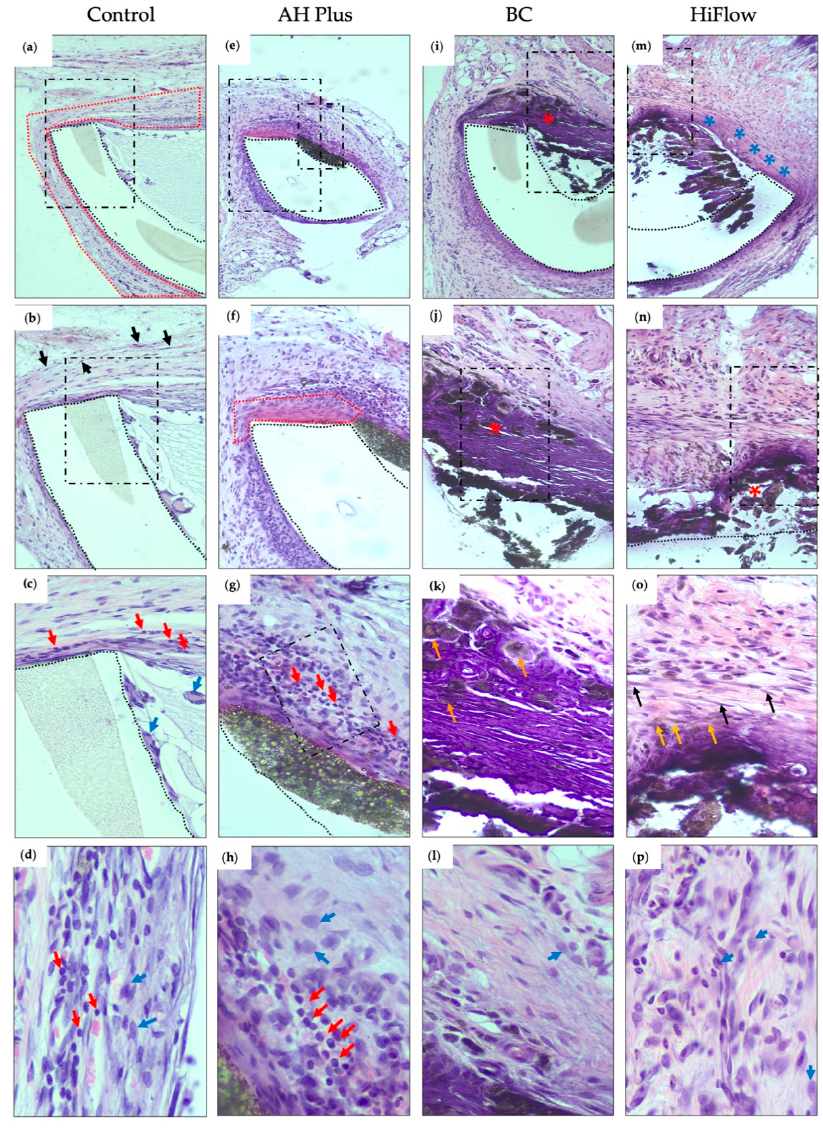
Figure 2. Hematoxylin and eosin histological sections of the interface tissue-sealer 30 days after subcutaneous implantation (dashed boxes mark the view of the subsequent image): ( a ) control group, showing the polyethylene tube (demarcation with dotted lines) and content surrounded by a thin fibrous capsule (demarcation with dotted red line) (100 × ); ( b ) high magnification detailing the fibrous capsule with fibroblasts (black arrows) and some inflammatory cells (score 1) (200 × ); ( c ) high magnification showing fibroblasts in collagenous stroma and some lymphocytes (red arrows) and macrophages (blue arrows) adjacent to the polyethylene tube (400 × ); ( d ) inflammatory infiltrate (800 × ); ( e ) AH Plus group, showing fibro-inflammatory reaction around the polyethylene space and the material (100 × ); ( f ) higher magnification demonstrating a thin fibrous capsule (demarcation with dotted red line) and inflammatory cells (score 2) next to the polyethylene tube and the material (200 × ); ( g ) higher magnification to observe a thin bundle of fibroblasts surrounded and permeated by lymphocytes (red arrows) (400 × ); ( h ) macrophage (blue arrows) and lymphocytes (red arrow) infiltrate (800 × ); ( i ) BC group, revealing a thick fibrous capsule with extensive calcification (red asterisk) (100 × ); ( j ) higher magnification showing intense calcification (bluish aspect) in the fibrous capsule, and the sealer immediately adjacent to the calcified capsule (red asterisk) (200 × ); ( k ) higher magnification demonstrating birefringent material deposited in the fibrous and calcified capsule (orange arrow) (400 × H&E). ( l ) Macrophage infiltrate (blue arrow) (800 × ); ( m ) HiFlow group, revealing the material inside the polyethylene tube, surrounded by a fibrous capsule (blue asterisk) and calcification of almost the entire capsule opening (100 × ); ( n ) high magnification with fragmentation of the calcified area/tissue (red asterisk) (200 × ); ( o ) high magnification revealing in detail the fibroblasts (fusiform cells—black arrow), collagen deposits and calcified deposits inside the fibrous capsule (orange arrow) (400 × ); ( p ) macrophage infiltration (blue arrow) (800 × ). ( n =